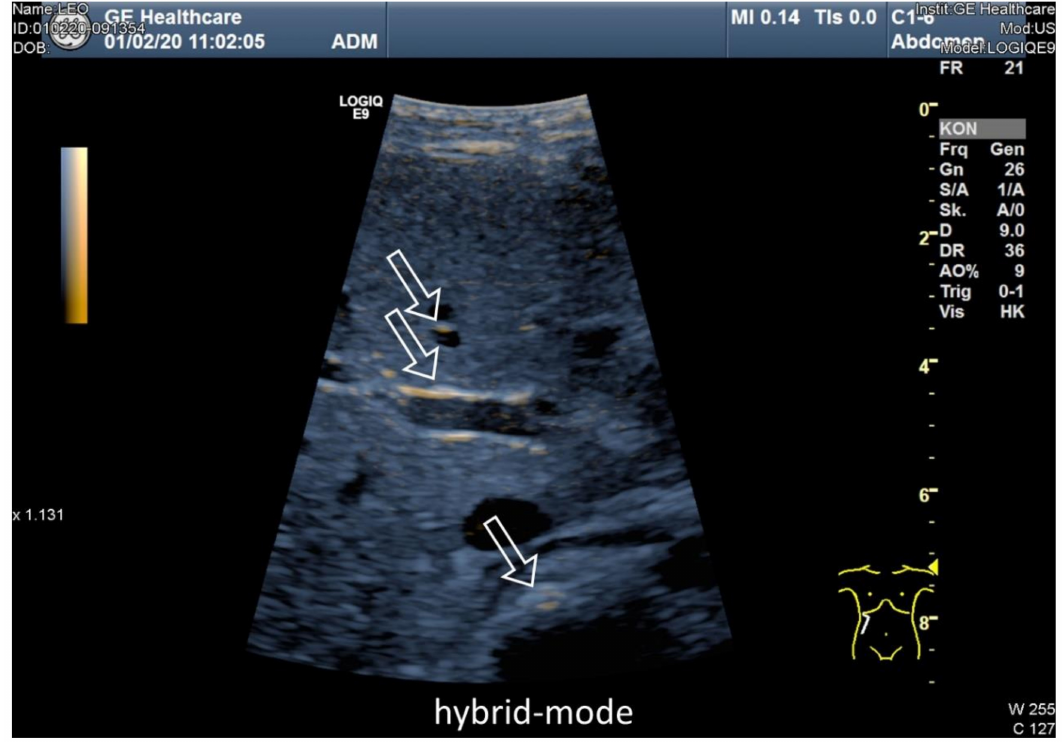
Figure 7. Ultrasound image of liver. Visualization of the microbubbles with the hybrid subtraction mode. Clear enhancement of the bubbles in the larger and smaller liver vessels (arrow).